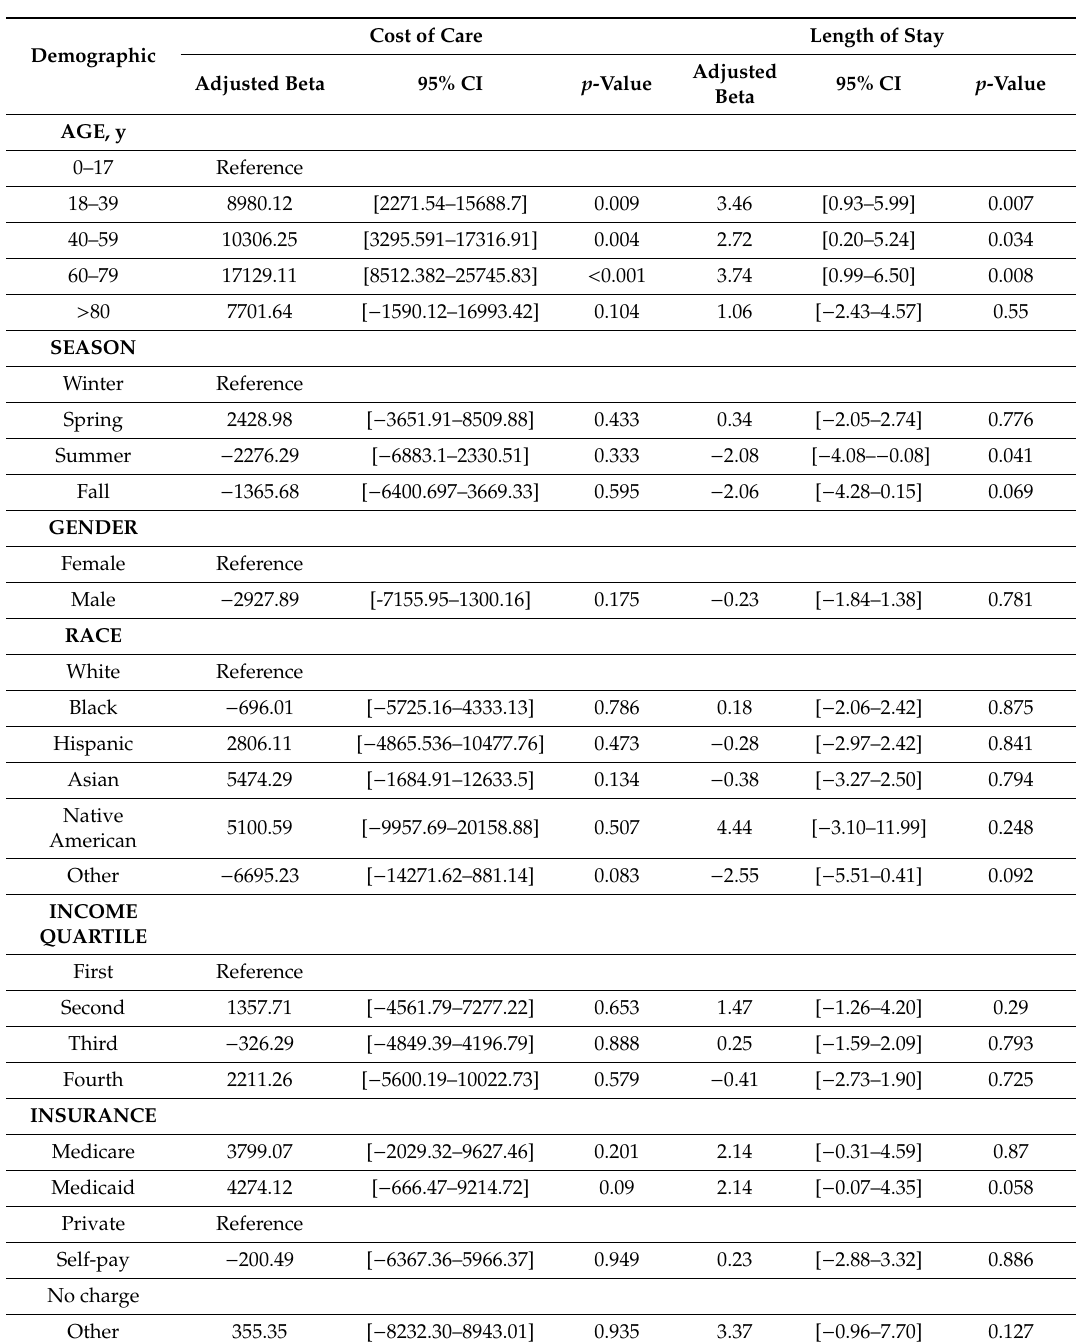
Table 2. Multivariate linear regression for the cost of care and length of stay among prurigo nodularis